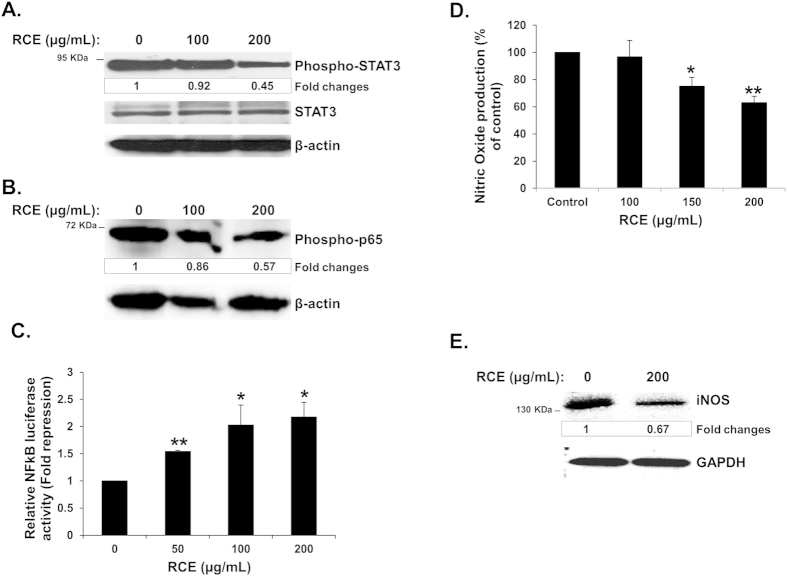
Downregulation of STAT3, NFκB and iNOS and Reduction of Nitric Oxide (NO) production in Rhus coriaria-treated MDA-MB-231 cells.(A) Concentration-dependent decrease of phospho-STAT3 in RCE-treated MDA-MB-231 cells. MDA-MB-231 cells were treated with vehicle (0.2% ethanol) or indicated concentrations of RCE for 24 h, then whole-cell extracts were subjected to Western blot analysis for the phosphorylated and non-phosphorylated form of STAT3 and for β-actin (loading control). (B,C) Inhibition of the NFκB signaling pathway by RCE. (B) Western blot analysis showing a concentration-dependent decrease of phospho-p65 (NFκB) in MDA-MB-231 cells in response to RCE treatment. (C) Inhibition, by RCE, of NFκB transcriptional activity in MDA-MB-231 cells. MDA-MB-231 cells were transfected with the pGL4.32[luc2P/NFκB-RE/Hygro] expression plasmid and luciferase activity was measured 18 h post-transfection as described in Materials and Methods. Columns represents mean; bars represents SEM of three independent experiments. Statistical analysis was performed using one-way ANOVA (*p < 0.05, **p < 0.005, ***p < 0.001). (D–E) Reduction of Nitric Oxide (NO) production and downregulation of iNOS in RCE-treated MDA-MB-231 cells. (D) Quantification of NO levels in RCE-treated MDA-MB-231 cells. Cells were treated with vehicle (0.2% ethanol) or indicated concentrations of RCE for 24 h and Nitrate/Nitrite production was quantified as described in Materials and Methods. Statistical analysis was performed using one-way ANOVA (*p < 0.05, **p < 0.005, ***p < 0.001). Data represents means ± SEM of three independent experiments carried out in triplicate. (E) Western blot quantification of iNOS in cells treated without or with the indicated concentration of RCE. For western blot, each lane was loaded with 25 μg of whole cell extracts. Loading was normalized to the levels of β-actin.The intensities of the bands were quantified using the ImageJ software (National Institute of Health, USA).